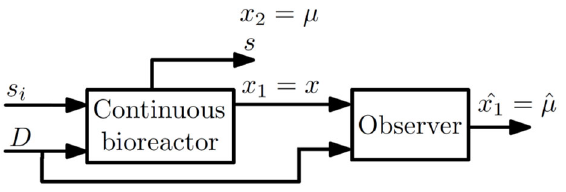
Figure 4. Structure of the observer application to microalgae bioreactor for estimation of the specific growth rate 𝜇 .